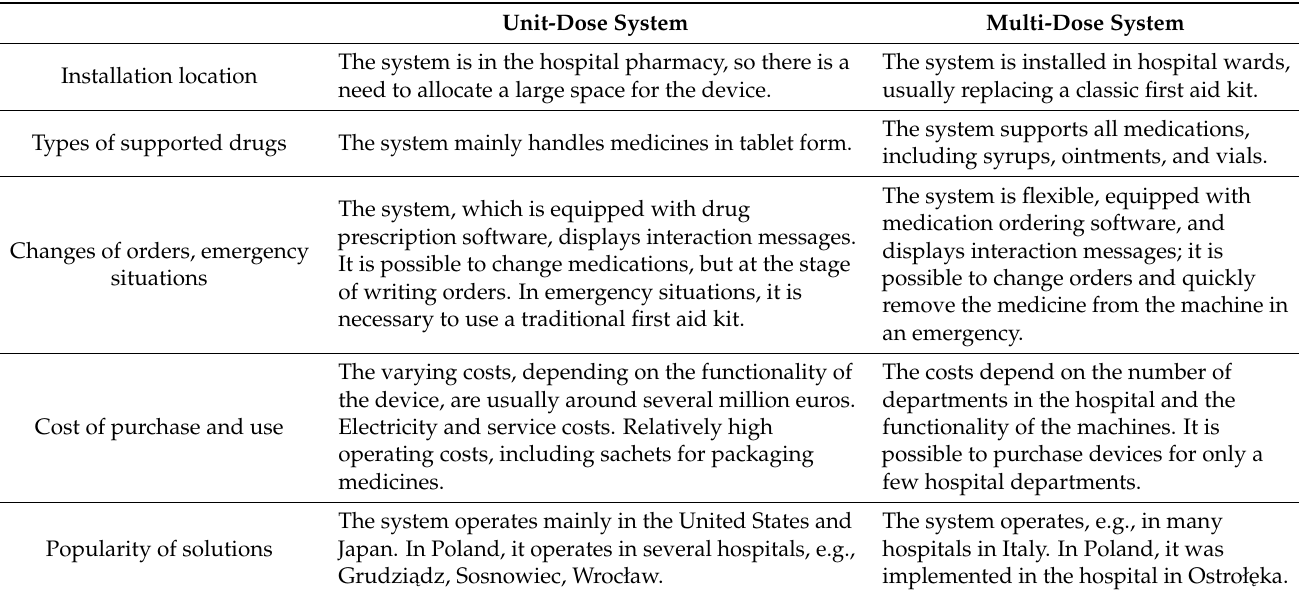
Table 1. Comparison of multi-dose and unit-dose